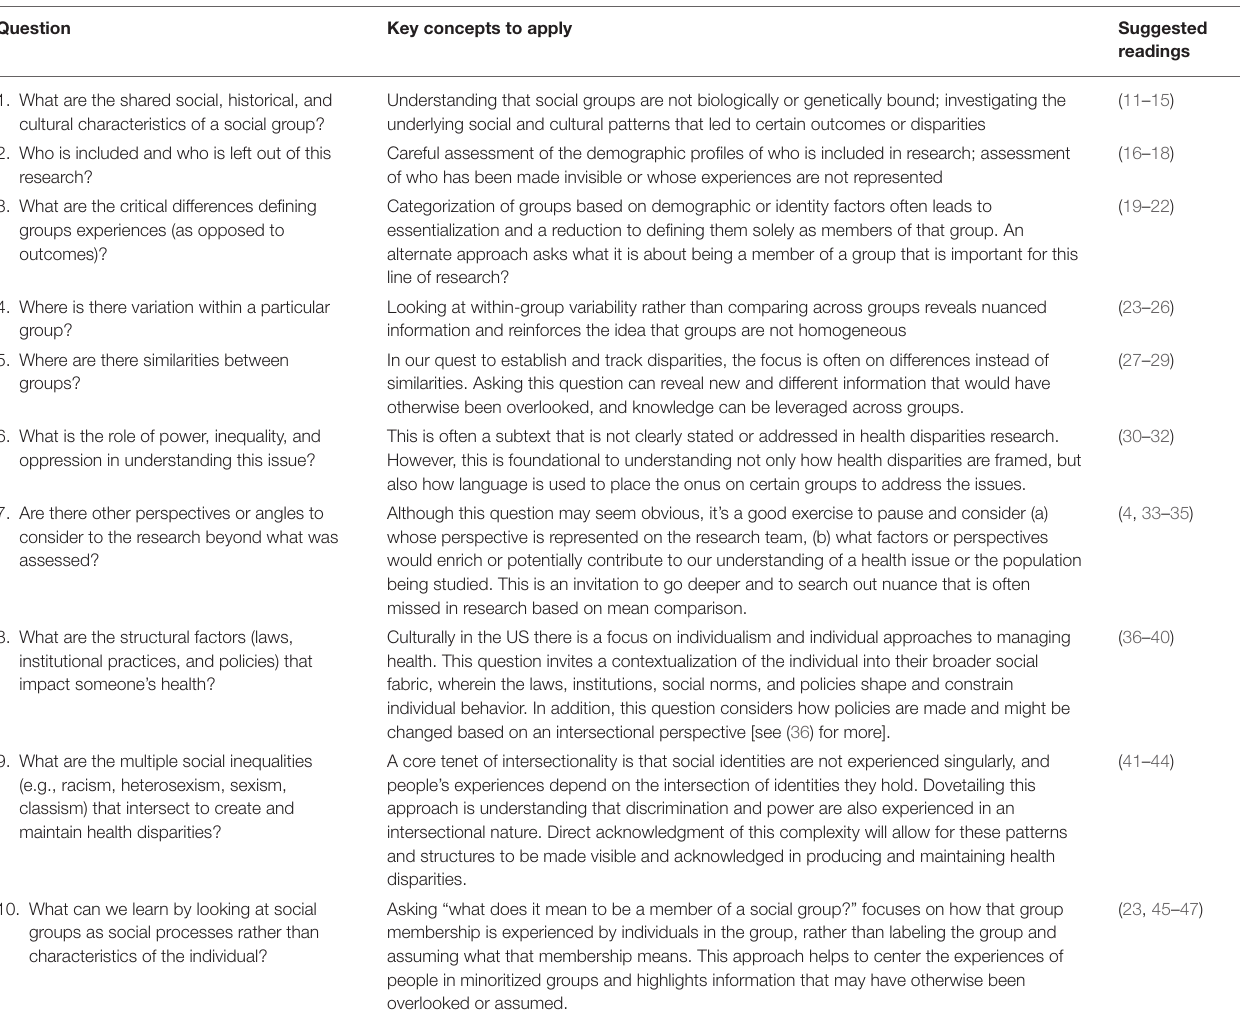
TABLE 1 | Intersectionality toolbox questions, main concepts, and suggested